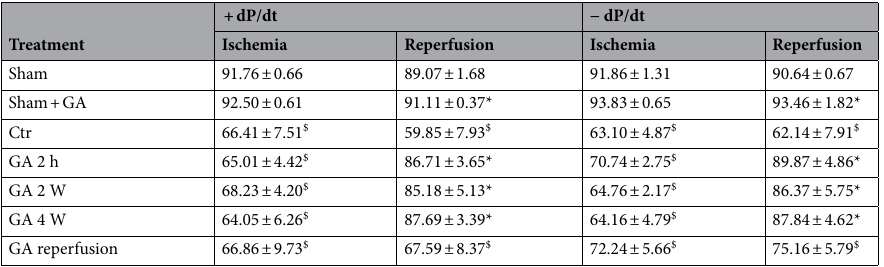
Table 1. Effects of ischemia/reperfusion and GA treatment on heart contractility (n = 8). Ctr control, GA 2 h gum arabic infusion 2 h before sacrifice, + dP/dt and − dP/dt left ventricle contractility indices, GA 2 W gum arabic administration for 2 weeks, GA 4 W gum arabic administration for 4 weeks, Rep Reperfusion. *P < 0.05 compared to control and $ P < 0.05 compared to sham and sham +